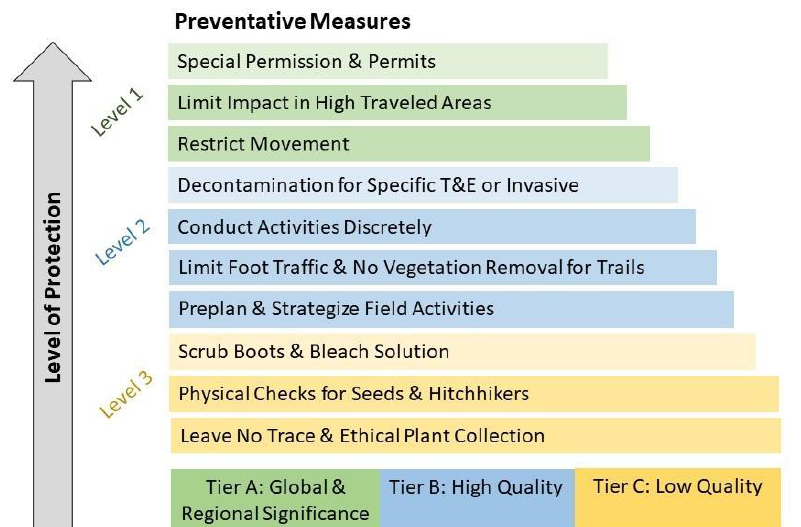
Figure 2. Recommended preventative measures for each level based on the wetland tier, where Tier A is the highest quality wetlands, Tier C is the lowest quality wetlands, and Level 1 affords the highest level of protection and includes all preventive measures included under Levels 1, 2, and 3.